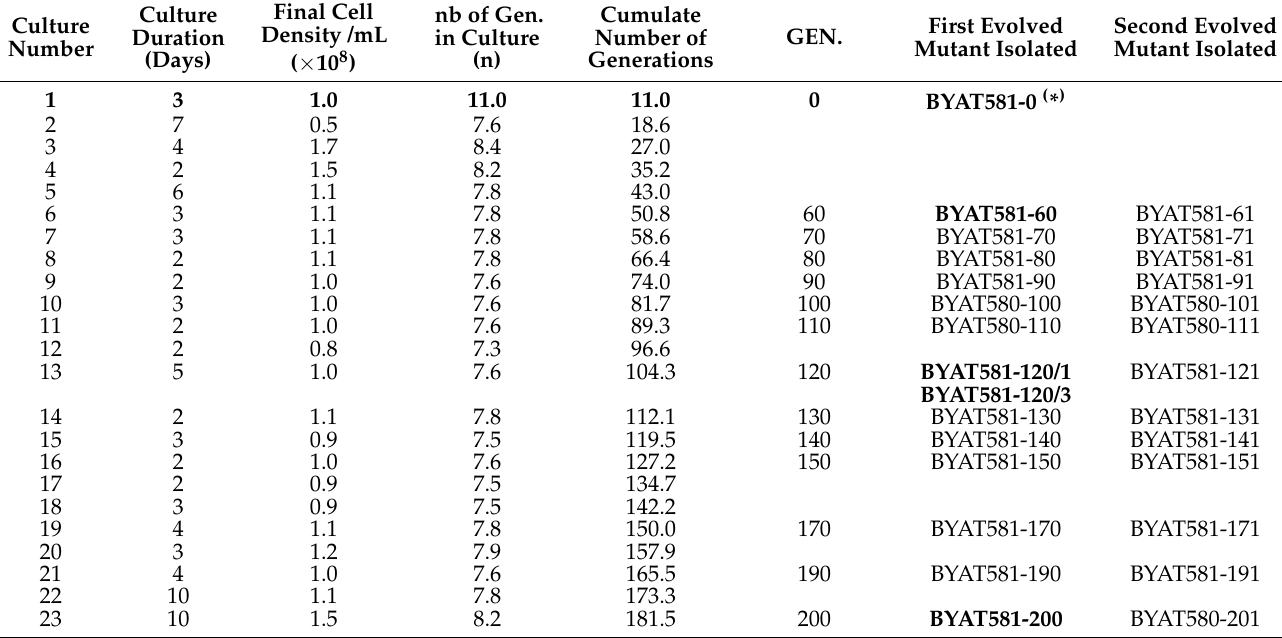
Table 1. Evolutionary trajectory of the BYAT581 population.